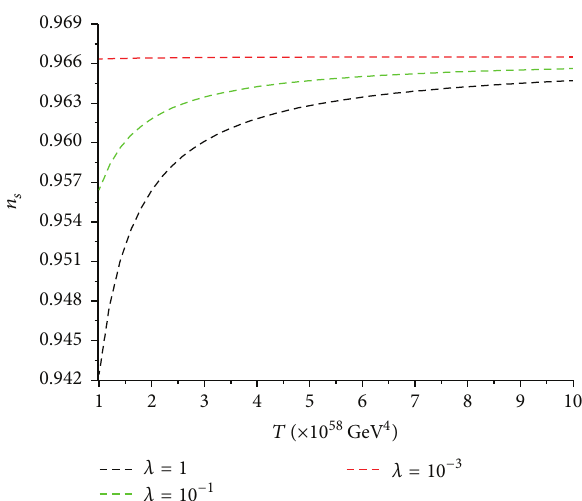
Figure 3: 𝑑𝑛 𝑠 /𝑑 ln (𝑘) versus 𝑇 for different values of 𝜆 for 𝜉 𝑐 = 3/16 and 𝑁 = 60 .